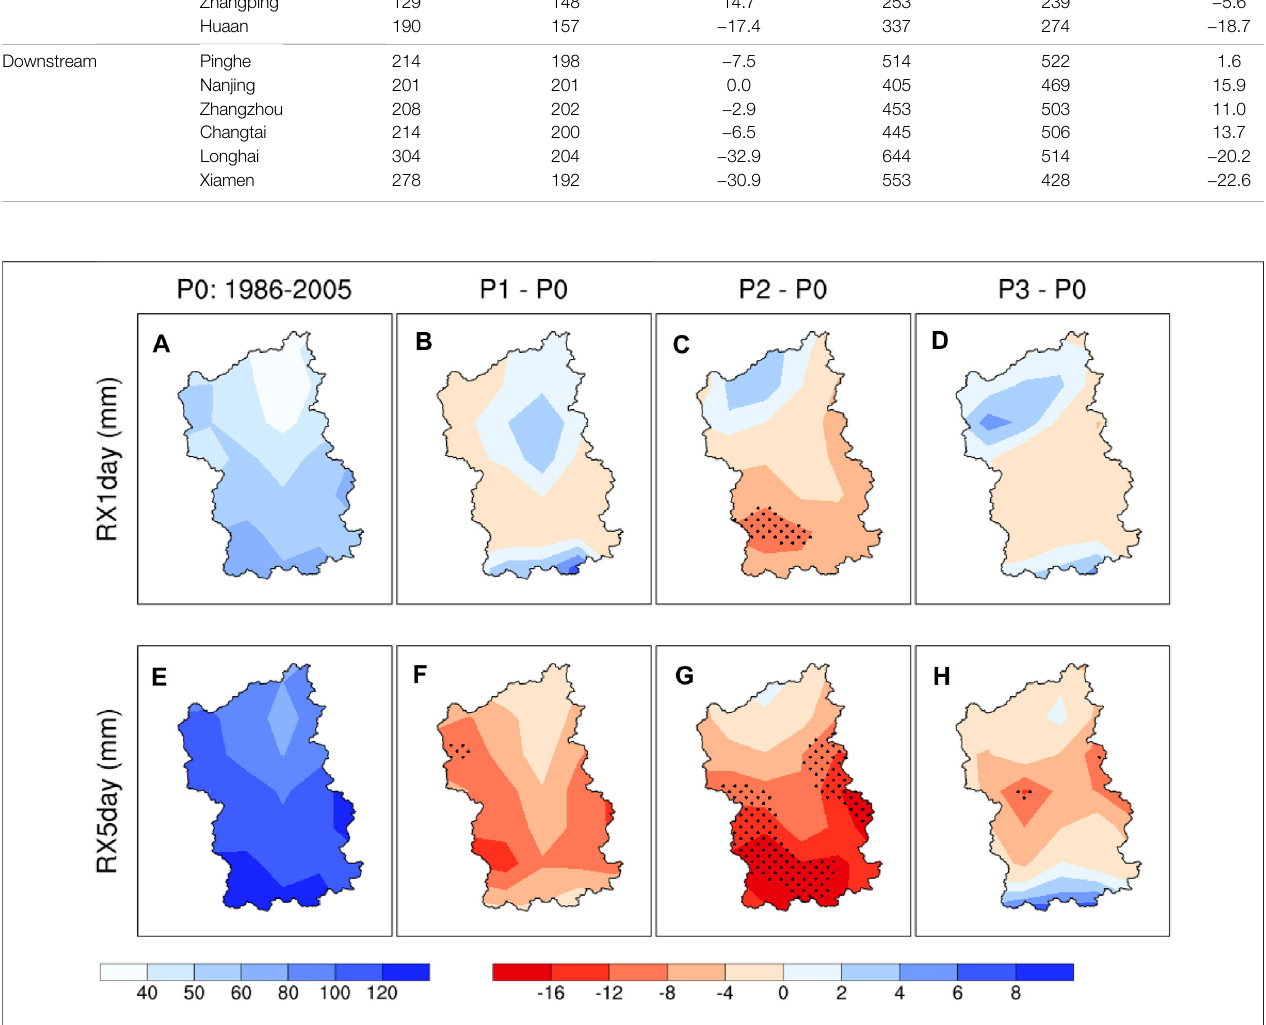
Frontiers in Earth Science |